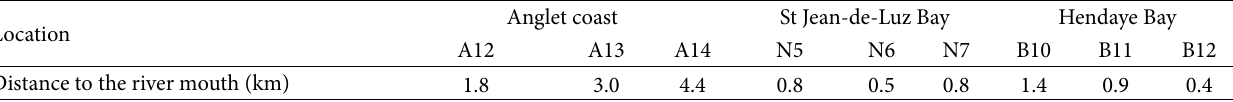
Table 1: Distance between the sampling stations and the river mouth for each